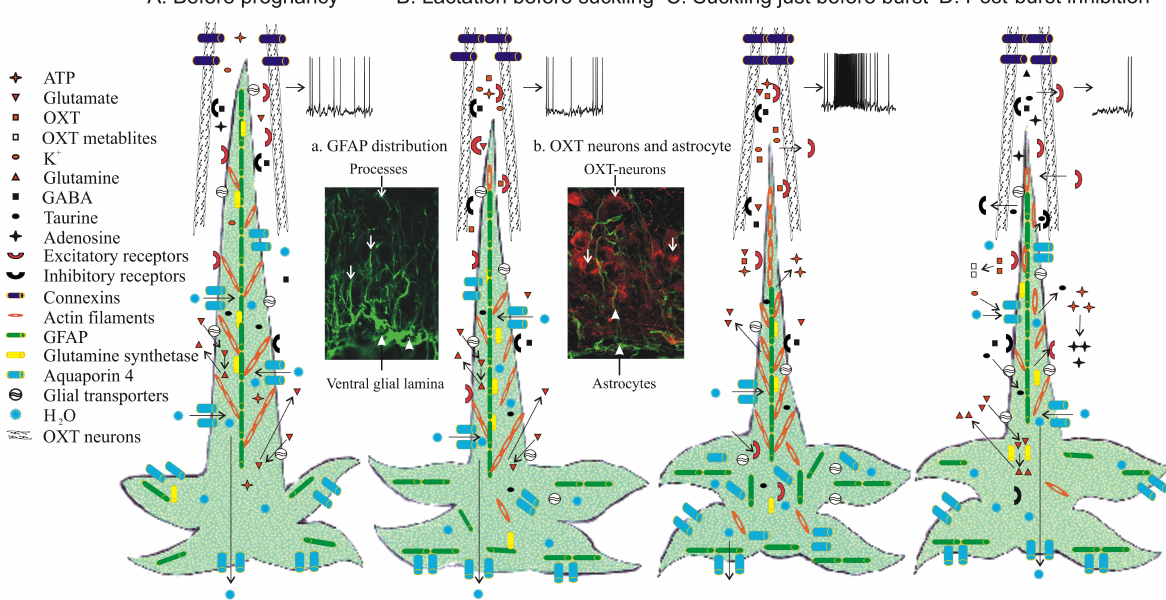
FIGURE 1. Mechanisms underlying chronic and acute stages of GFAP plasticity and astrocyte-OXT neuron interactions in the SON. An astrocyte cell body and a vertical process extending dorsally from ventral glial lamina are shown in green. The vertical process is interposed between plasma membranes of two OXT neurons (dashed lines). (A–D) GFAP plasticity before pregnancy (A); during lactation, but before suckling (B); during suckling, but before the first milk ejection (C); and immediately following the third or fourth milk ejection during suckling (D). Inset “a” shows confocal image of GFAP distribution (in green) in the SON: white arrowheads, ventral glial lamina-located astrocyte somata; white arrows, vertically oriented astrocyte processes. Inset “b” shows dorsally located OXT-neurophysin–positive OXT neurons (white arrows, red) and they are interposed by GFAP-positive astrocyte processes (arrowheads, green). (A) GFAP levels and distribution are dynamically related to neurotransmitter/modulator levels, receptor expression, levels of amino acid transporters, water channel expression, and associated K + permeability, membrane localization and activity of intracellular enzymes, and actin cytoskeleton dynamics. Before and during the early stage of pregnancy, GFAP metabolism and the factors are shown in a state of dynamic balance, which permits continuous firing of OXT neurons. (B) Following the reduction in sex steroid hormones and increases in OXT levels that occur in the SON around parturition, GFAP levels are reduced in vertically orientated astrocyte processes, and increased in the somata. In this state, increased extracellular levels of OXT and OXTR trigger breakdown of GFAP and retraction of the interposed astrocyte processes, leading to apposition of OXT neuronal membranes, gap junctional communication, and increased chemical synaptic innervation. (C) Brief suckling stimulation increases OXT secretion and results in further depolymerization and decomposition of GFAP in the interposed processes, volume expansion of somata and proximal processes, and secondary release of ATP and glutamate from astrocytes. Together with intracellular mechanisms proposed previously (see review by Hatton and Wang[48]), these factors trigger burst discharges of OXT neurons. During this process, receptors of excitatory agents are gradually desensitized. (D) Each burst discharge triggers bolus release of ATP and glutamate from OXT neurons as well as astrocytes; in astrocytes, GFAP reduction reverses and amino acid transporters are inserted, leading to decreases in extracellular glutamate and K + , reduction of junctional communication, increases in adenosine and taurine levels, and activation of metabolic glutamate and glycine receptors. This produces a period of silence following the bursts. At the same time, more glutamine will be made available by glutamine synthetase activity, taurine will be taken up, and OXT neuronal sensitivity to OXT and glutamate will be restored. Together, this results in gradual excitation of OXT neurons and retraction of the apposed astrocyte process accompanied by redistribution of